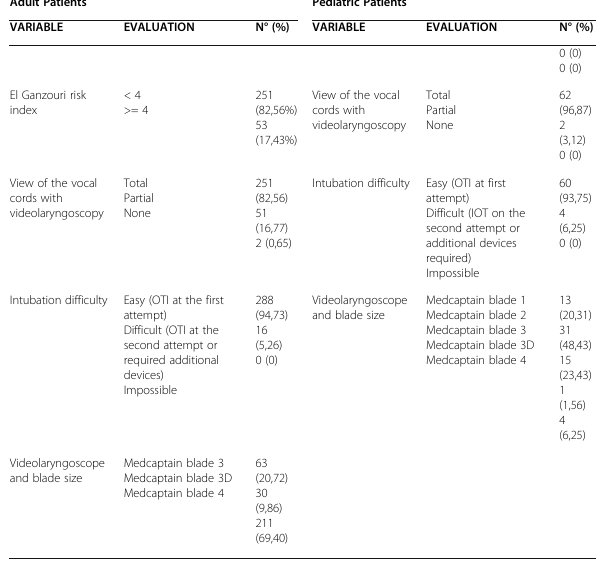
Table 1 (abstract A168). Results (Continued) Adult